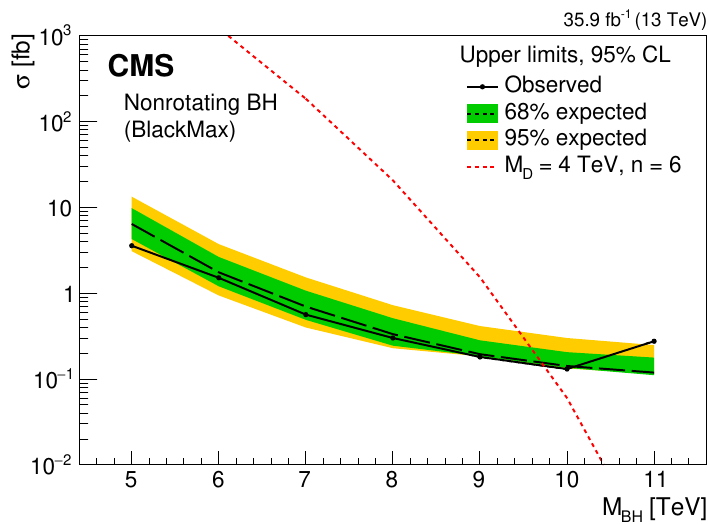
Figure 8 . Example of a model-speci(cid:12)c limit on M min model ( BlackMax point B1) with M D = 4 TeV n ED = 6, as a function of M min CL upper exclusion limit on the signal cross section for each M min optimal ( N min ; S min ) point, which ranges from (7 ; 5 : 0 TeV) for M min T M min = 11 TeV. Also shown with a dashed line are the theoretical cross sections corresponding BH to these optimal